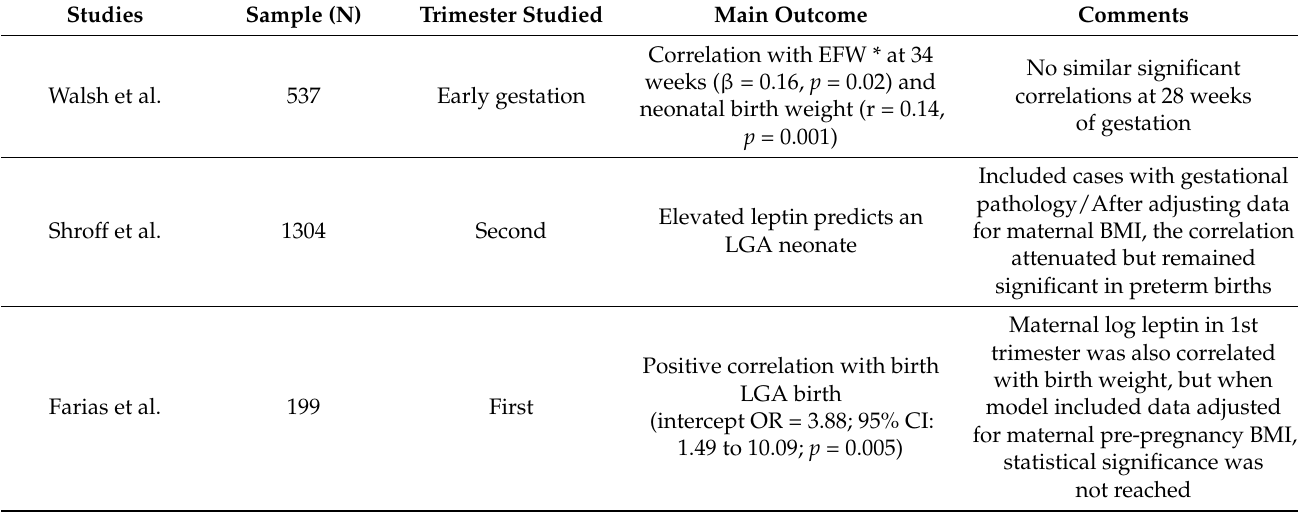
Table 3. Studies of maternal leptin levels in relation to neonatal anthropometric measurements at birth, with their data not adjusted to maternal BMI, gestational weight gain or both. * EFW: estimated fetal weight, ** SGA: small for gestational age, *** AGA: appropriate for gestational